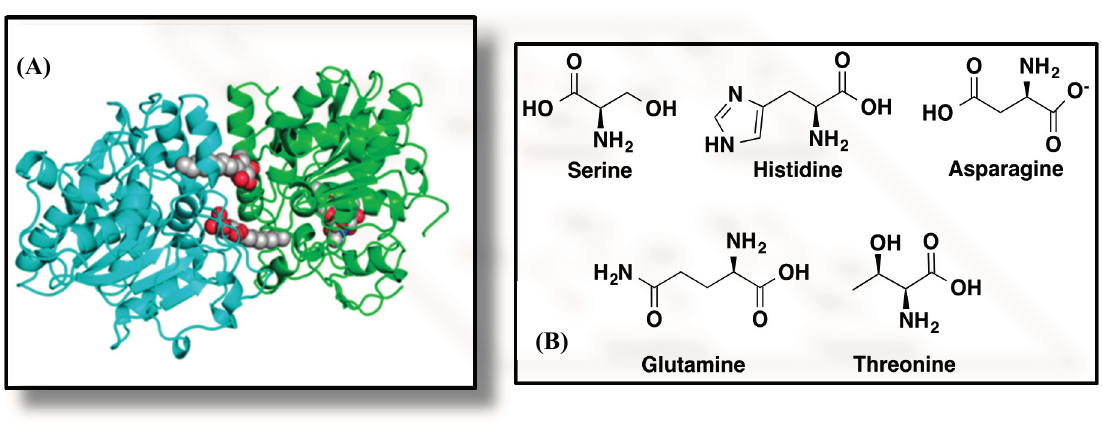
Figure 2. ( A ) 3D structure of CALB [16]; X-ray-diffraction with resolution of 2.10 Å created with Polyview 3D; ( B ) Structures of the amino acid residues forming the catalytic triad